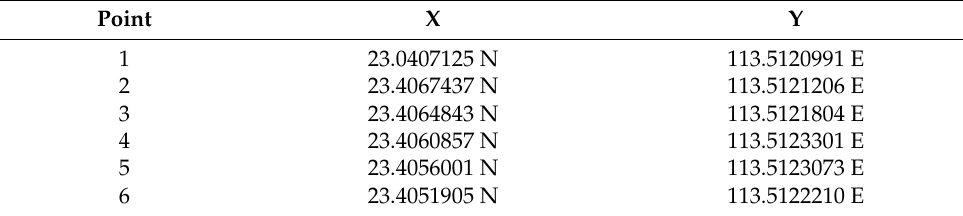
Table 3. Camera coordinates for the 6 different monitoring points shown in Figure 13.